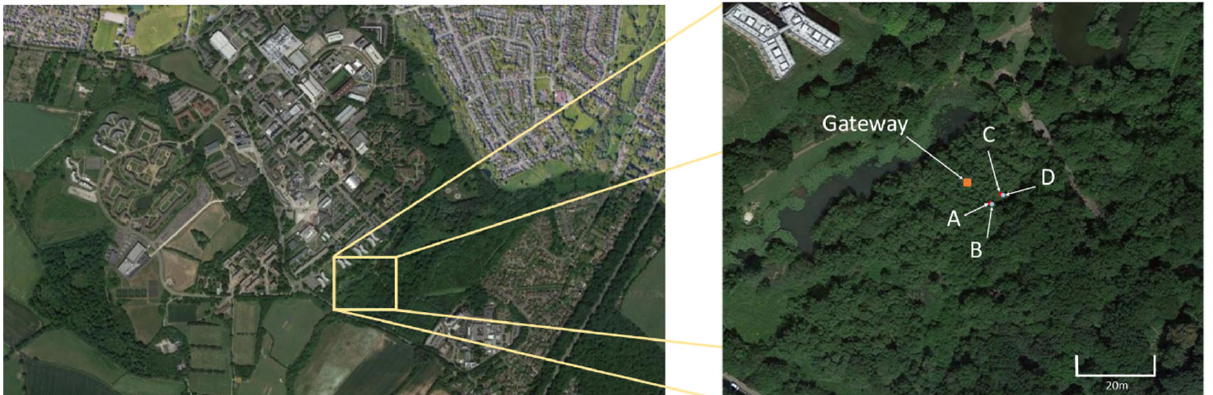
Figure 8. Satellite image of device location [Google Maps, accessed 29 March 2022]. Probes A&B in open woodland, C&D placed under tree.